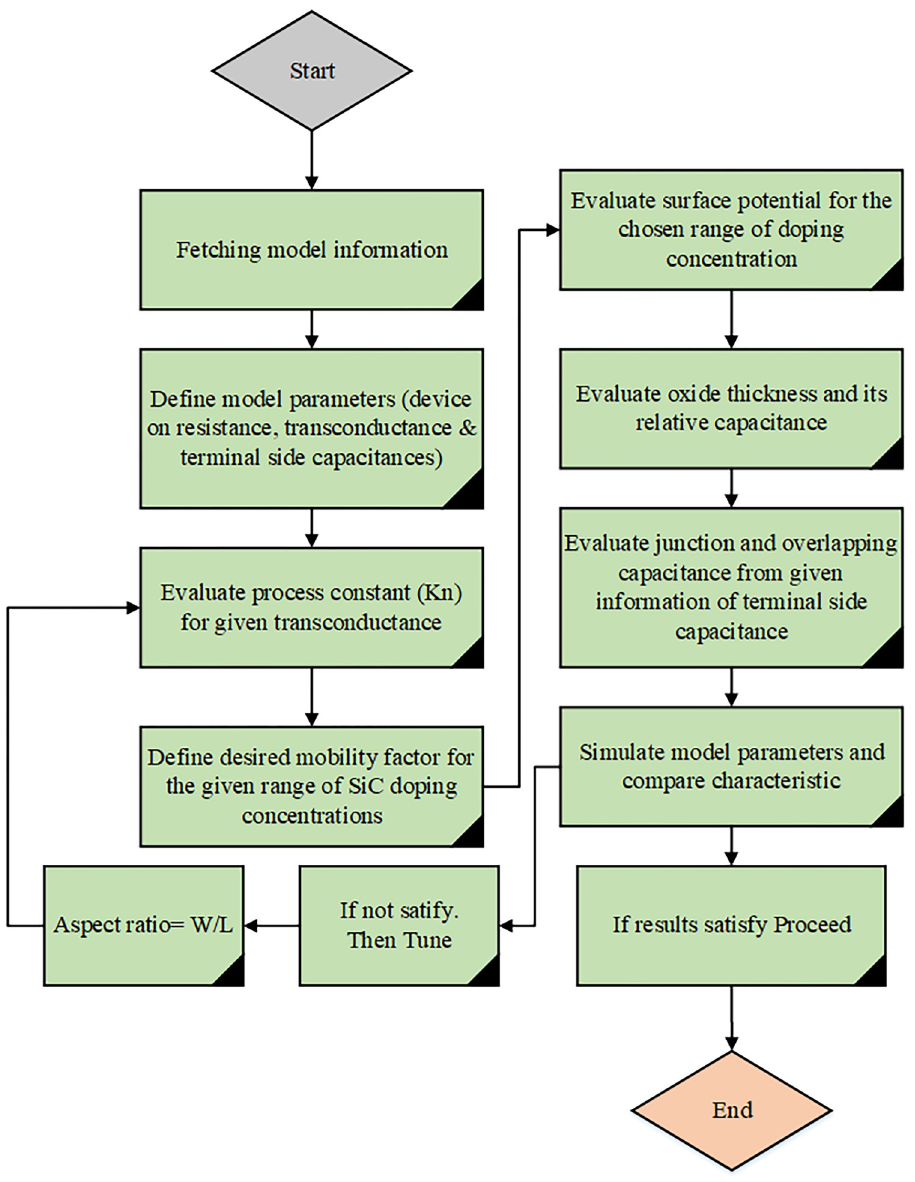
Fig 1. Process flow diagram for parameter